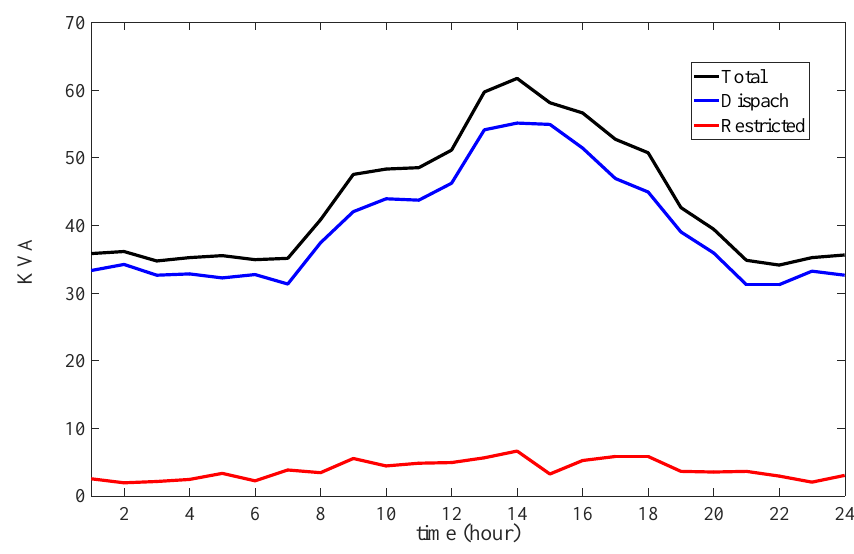
Figure 3. Demand behavior in the study case.